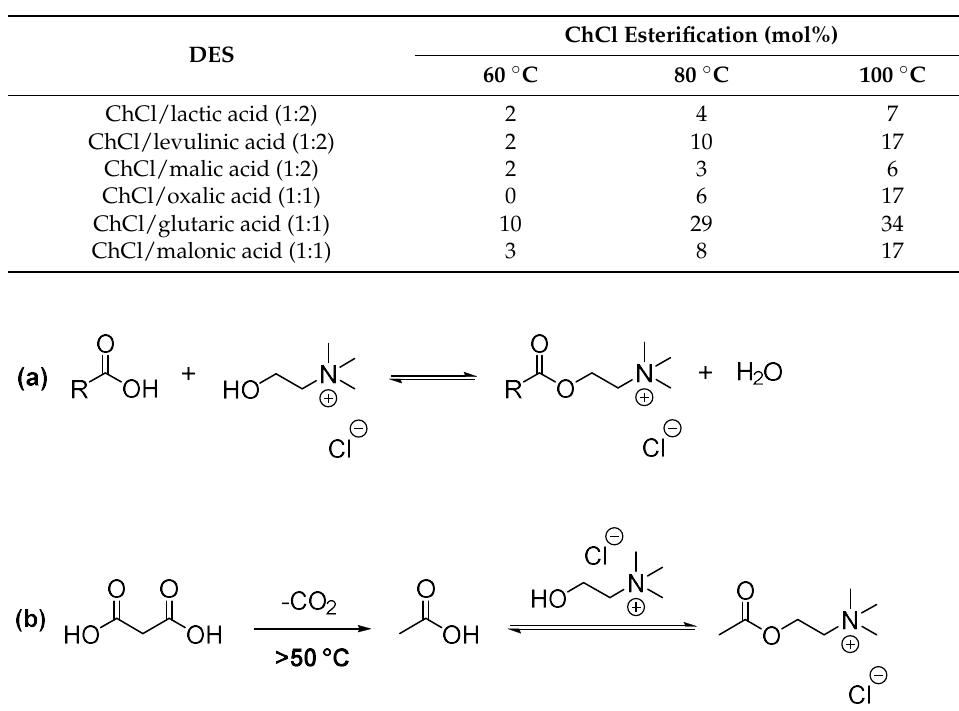
Table 3. Fraction of esterified ChCl in mol% after heating for 2 h at different temperatures estimated through 1 H NMR spectroscopy [61].